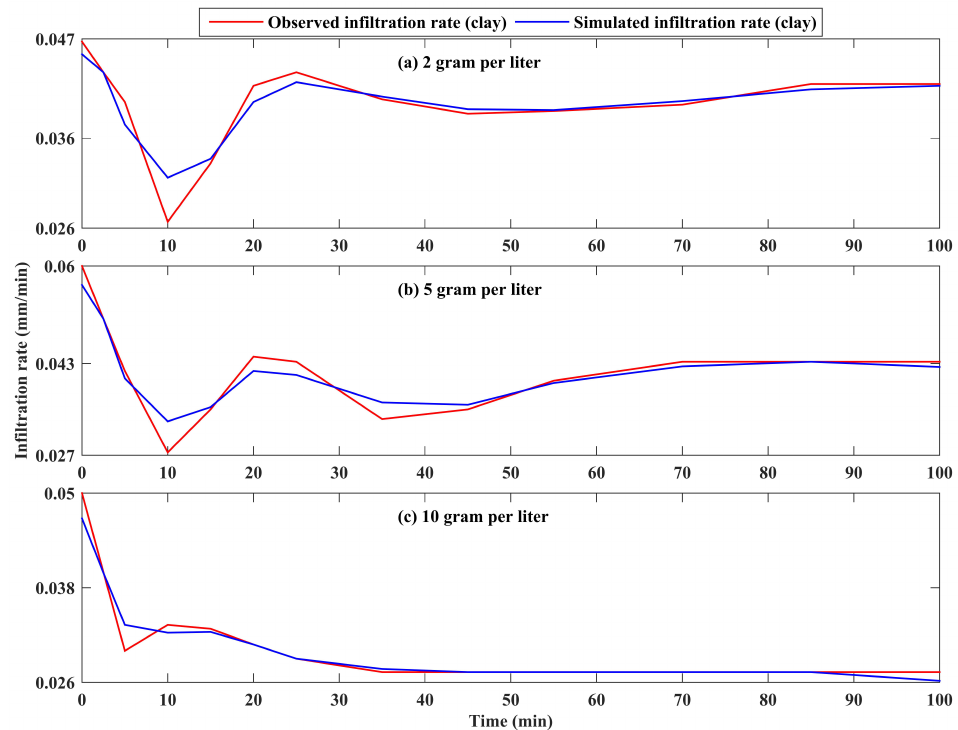
Figure 5. Comparison of the infiltration rate observed for the clean water (0 g/L) with that of the reconstructed using SSA for clay-sized suspended solids under three concentration levels 2, 5 and 10